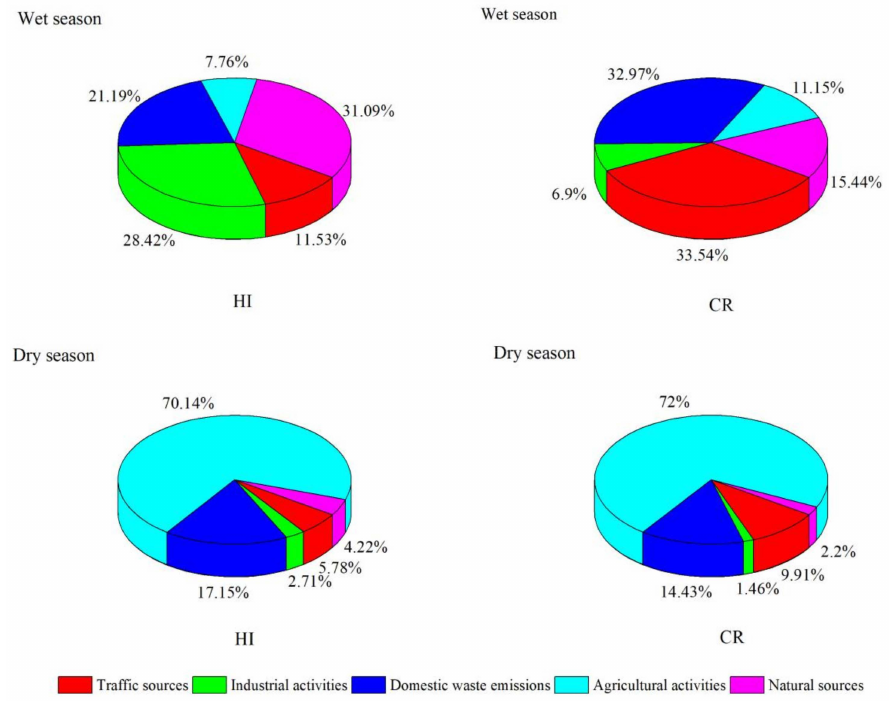
Figure 10. Cumulative probability of HI and CR from the identified pollution